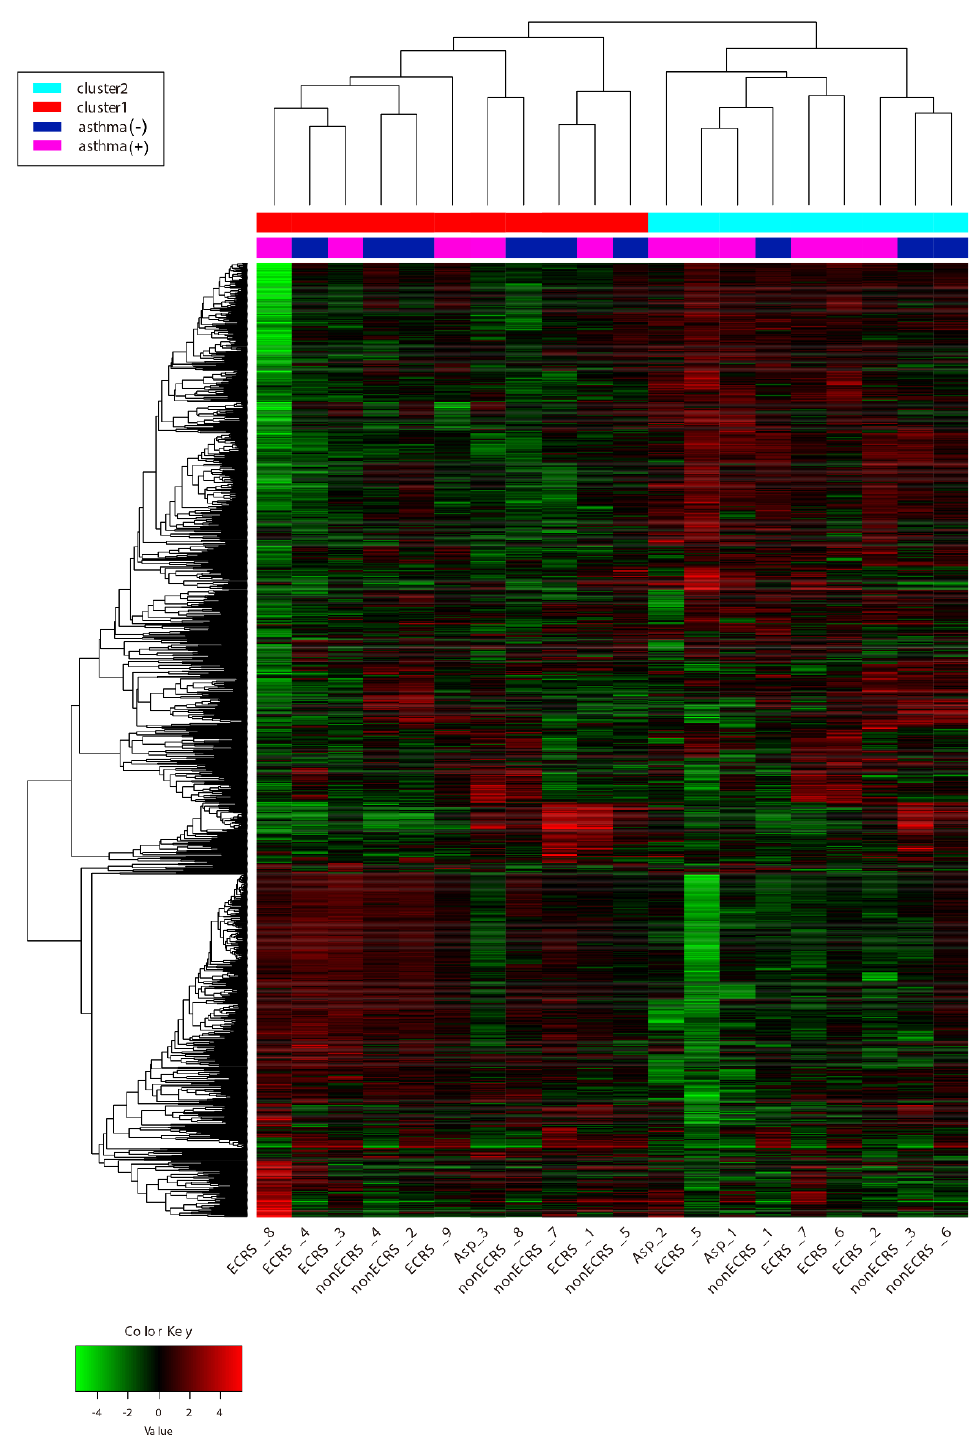
Figure 6. Hierarchic cluster analysis with all CRSwNPs segregated into two clusters (cluster1 and 2) among these CRSwNPs. Segregation of two clusters and comorbid of asthma were not correlated. The new clusters and control showed clear separation in the PCA analysis and DEGs (Figure